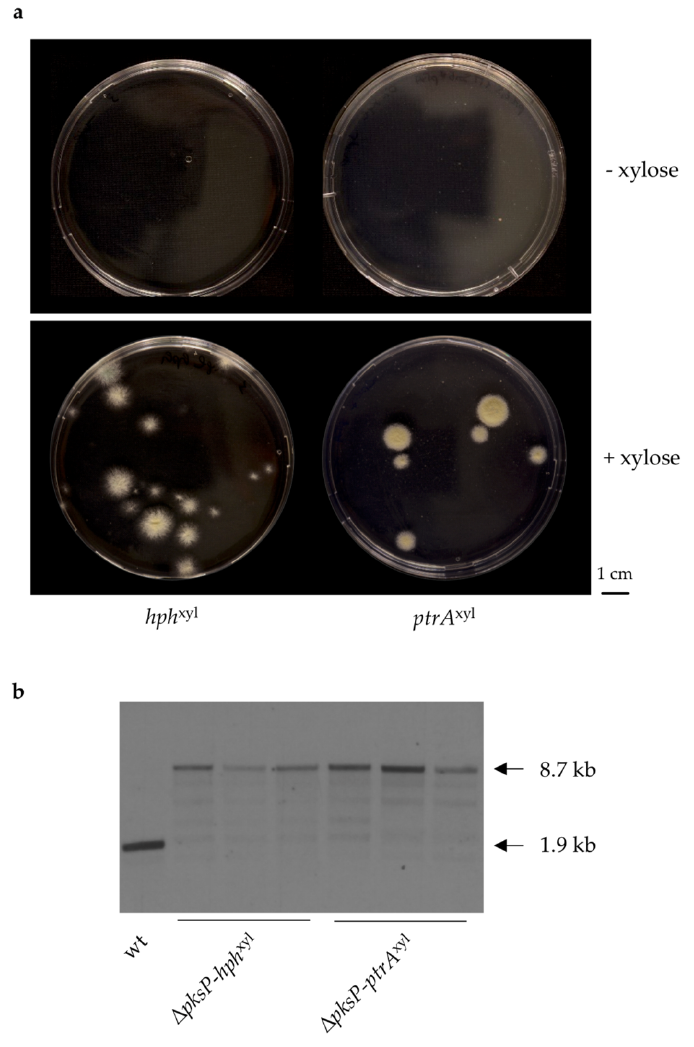
Figure 6. Transformation using hph xyl or ptrA xyl as a selectable marker. ( a ) Representative transfor- mation plates showing the transformation outcome when using the inducible marker hph xyl and ptrA xyl using hygromycin or pyrithiamine respectively, for selection. ( b ) Southern blot analysis of three random transformants for each marker in comparison to the wt. Genomic DNA was digested with BamH I, and the probe for detection was designed on the pksP 3 (cid:48) flanking region. Expected sizes are reported in the